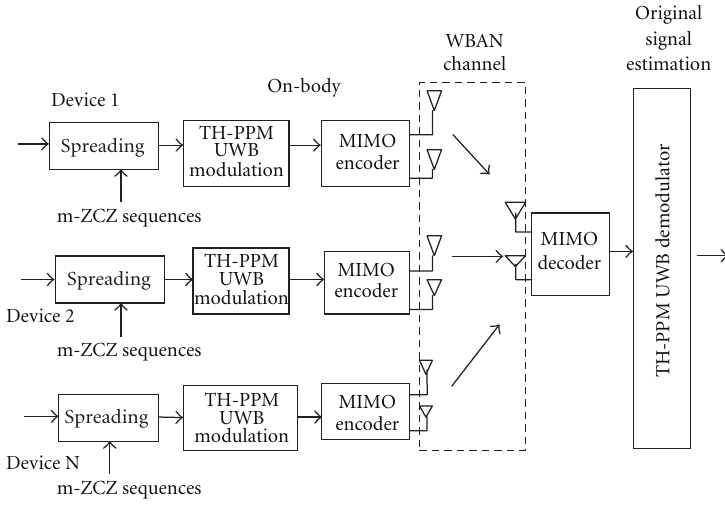
Figure 2: Proposed UWB/MIMO system using m-ZCZ